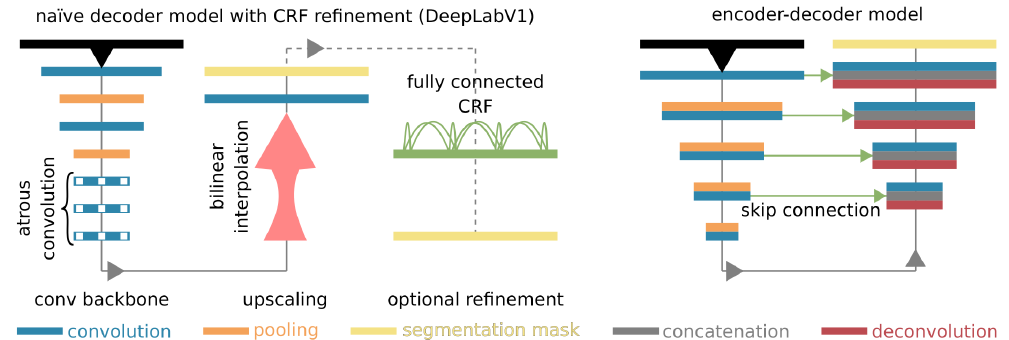
Figure 9. Evolution of milestone architectures for image segmentation from 2014 to 2019, compared by their mean intersection over union (mIoU) metric on the PASCAL-VOC 2012 test set for segmentation. Architectures marked with an * are tested on different datasets and no metric on PASCAL-VOC 2012 is reported.